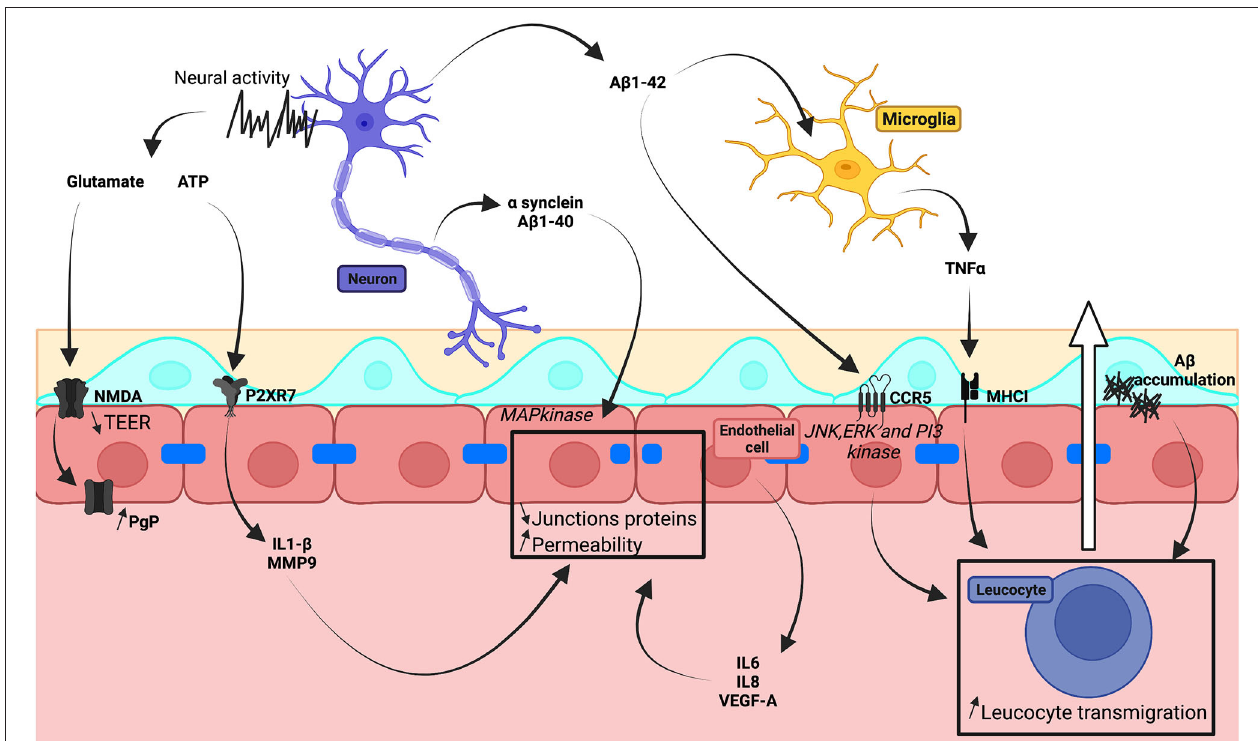
FIGURE 4 | Schematic illustration of neural dysregulation on in vitro human BBB